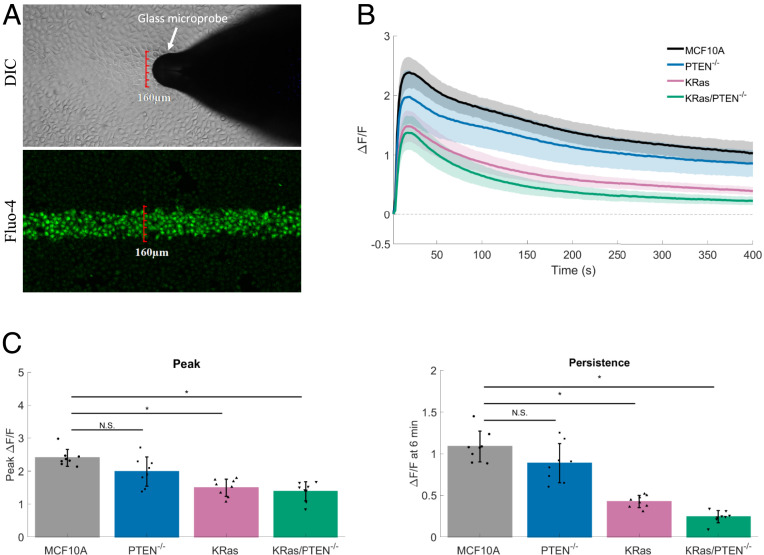
Constitutively active KRas but not PTEN loss reduces mechanoresponsiveness in MCF10A breast epithelial cells. (A) Mechanical stimulation of cells plated on 0.2-kPa substrates, termed mSLED (mechanical stimulation on low elastic modulus dishes), shows that only cells within the 160-µm-wide stimulus area (DIC) respond with rises in intracellular calcium (Fluo-4). (B) Traces show mechanically stimulated calcium signaling (ΔF/F) plotted over time for human breast epithelial cells (MCF10A), MCF10A PTEN null mutant cells (PTEN−/−), MCF10A constitutively active KRas (G12V) mutant cells (KRas), or MCF10A combination mutant cells (KRas/PTEN−/−). (C) Bar graphs show quantification of peak ΔF/F and ΔF/F at 6 min (persistence). The KRas and KRas/PTEN−/− mutation, but not PTEN loss alone, resulted in significant reductions in peak ΔF/F and ΔF/F at 6 min. Data are presented as mean ± SD. The asterisk (*) indicates significance, which was set at P < 0.05 via one-way ANOVA with a post hoc Tukey’s honest difference criterion. N.S. indicates no significant difference. Data represent n = 6 in total from six independent experiments for each group.